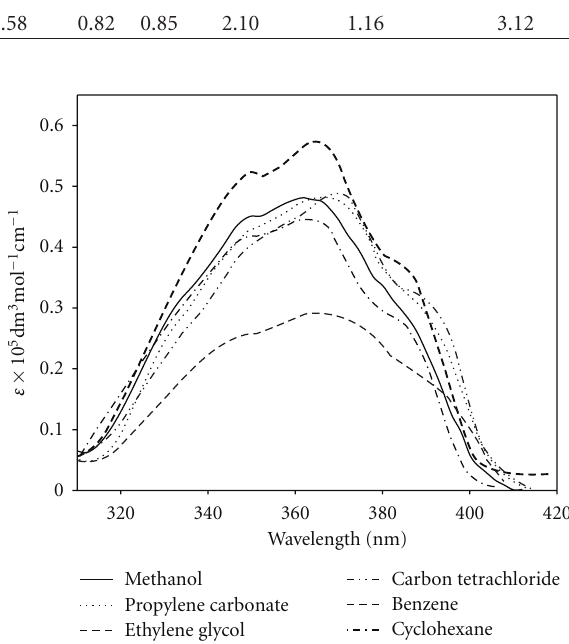
Figure 1: Absorption spectra of 1 × 10 − 5 moldm − 3 (POPOP) in di ff erent